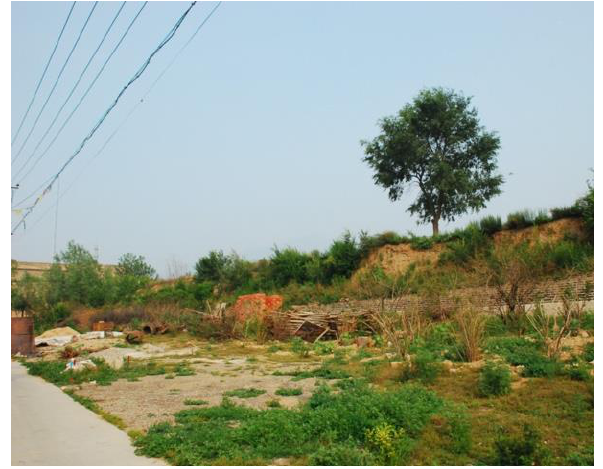
Figure 7. Present situation of plant diseases on the north town wall.